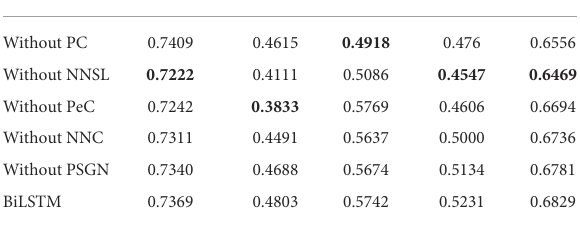
TABLE 2 Experimental results for ablation test.